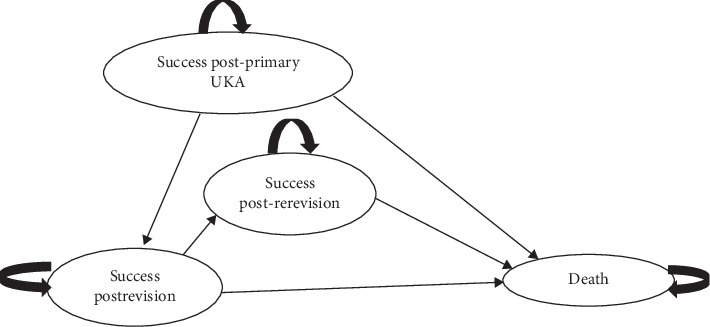
Schematic representation of the model structure.